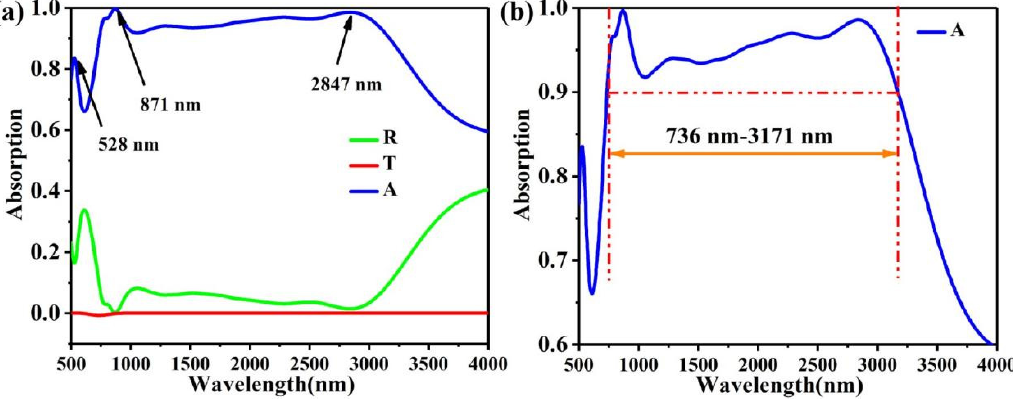
Figure 2. ( a ) The transmission, reflectivity, and absorption spectra of the absorber. ( b ) The absorption wavelength range of our absorber.